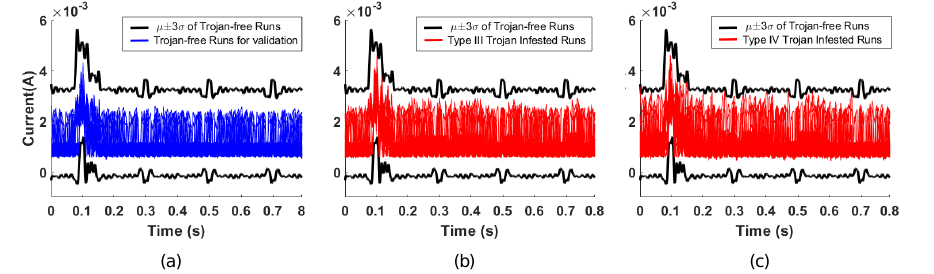
Figure 9. The µ ± 3 σ current consumption envelope of 500 Trojan-free runs and the current con- sumption of 100 Trojan-free runs ( a ), the current consumption of 100 Type-I Trojan-infested runs ( b ), and the current consumption of 100 Type-II Trojan-infested runs ( c ).